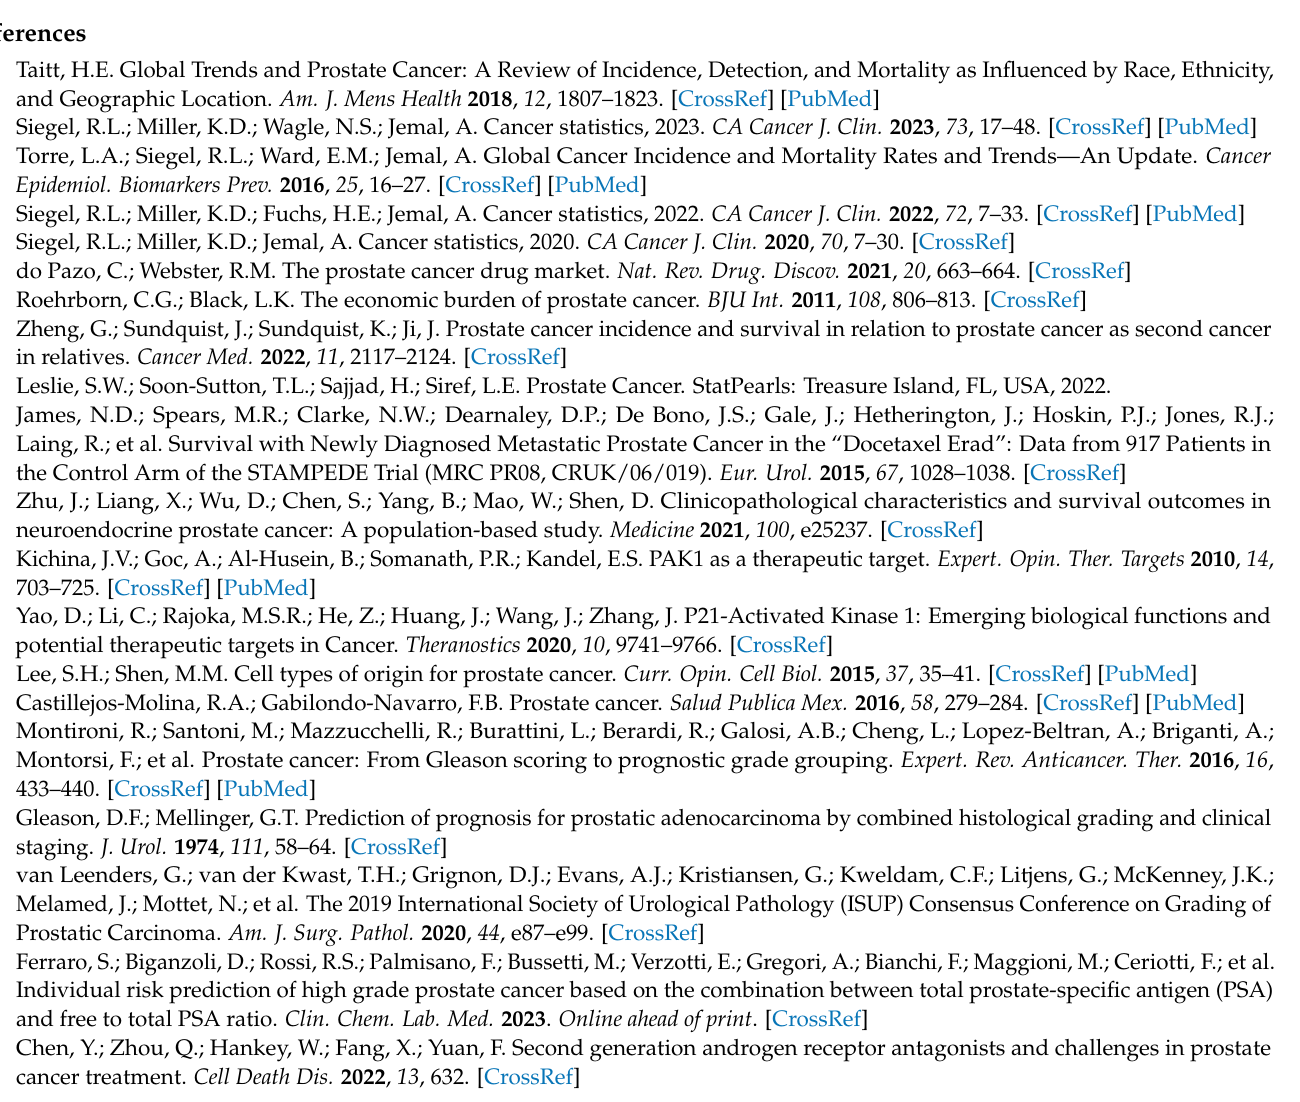
velop strategies to prevent and/or treat mPCa, independently of AR signaling modulation, and with minimal off-target